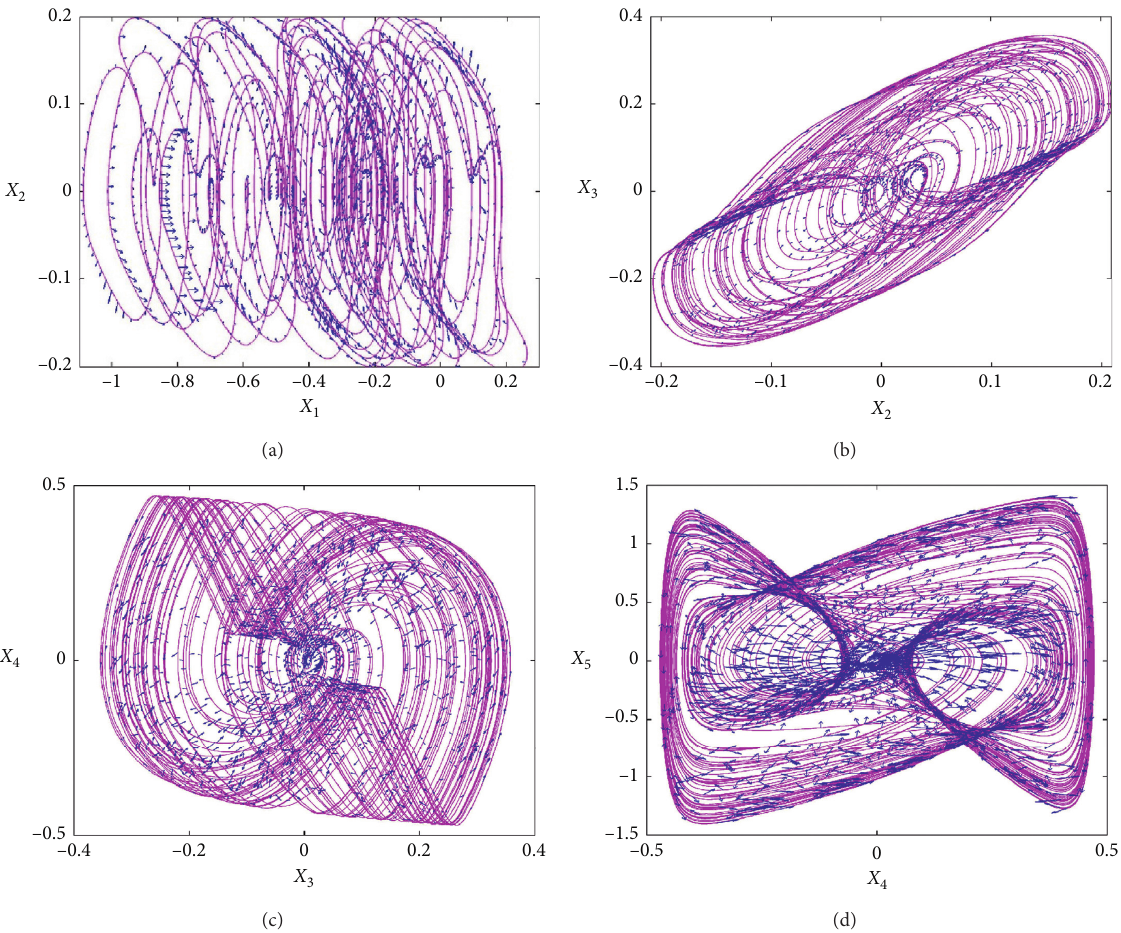
Figure 3: The positive Lyapunov vectors (LE1): (a) first and second components of positive Lyapunov vectors (LE1) in x second and third components of positive Lyapunov vectors (LE1) in x − x plane; (d) fourth and fifth components of positive Lyapunov vectors (LE1) in x vectors (LE1) in x 3 4